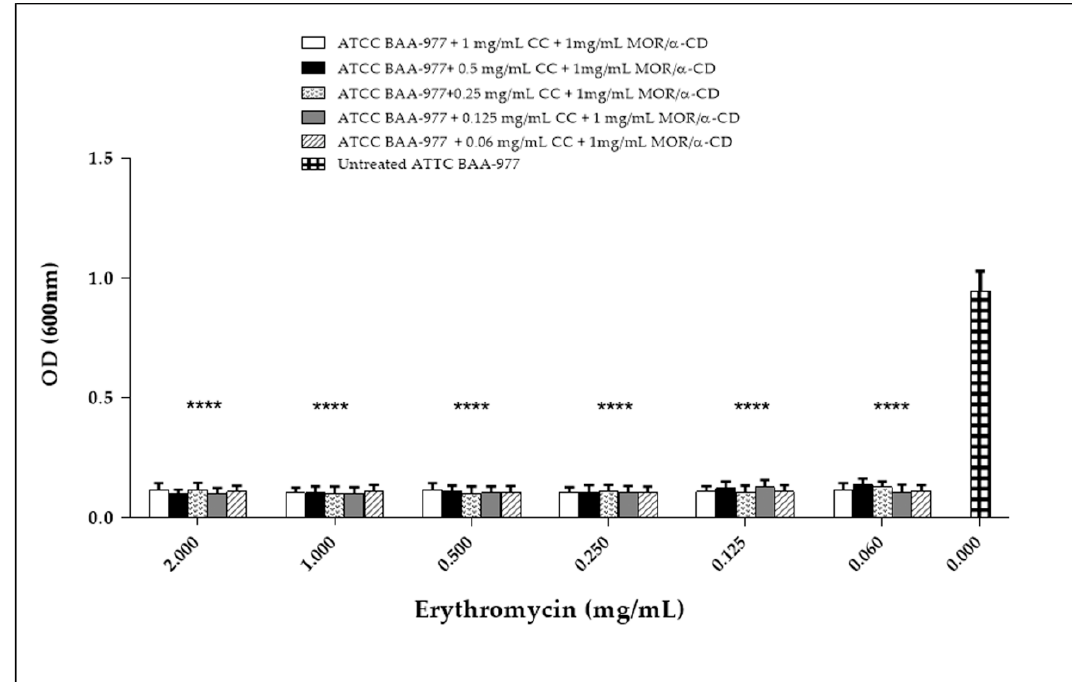
Figure 7. The MOR/ α -CD inhibition activity against the ATCC BAA-977 CC-resistant strain. The experiment was carried out adding 1 mg/mL of MOR/ α -CD for each microplate well filled with the combined doses of CC (1, 0.5, 0.25, 0.125, 0.06 mg/mL) and Ery (from 2 mg/mL to 0.002 mg/mL). The MOR/ α -CD inhibition activity was evaluated by measuring the OD reached after 24 h of treatment. The experiments were assessed in triplicate to obtain the mean and the standard deviation (SD). A